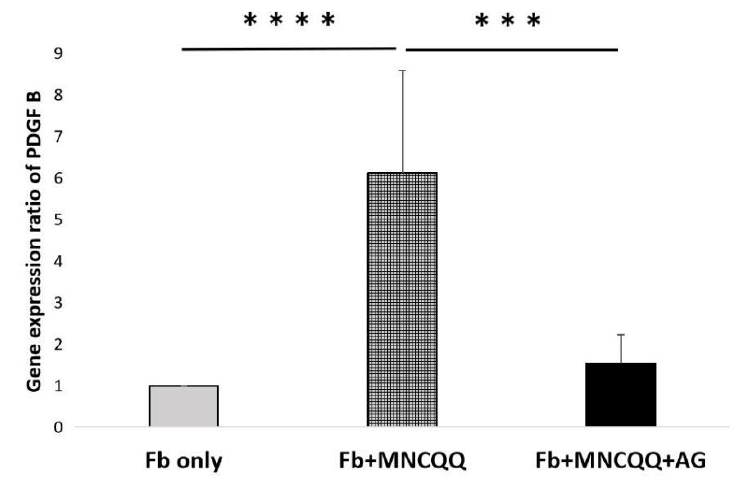
Figure 5. mRNA expression of PDGF B in fibroblasts under HG condition. Reverse transcription- quantitative polymerase chain reaction for the mRNA expression levels of PDGF B in fibroblast cells in the HG condition. N = 7 volunteers. ***; vs. Fb + MNCQQ, p < 0.005; ****; vs. Fb + MNCQQ, p < 0.001 Fb only: fibroblasts only in high glucose; Fb + MNCQQ: fibroblasts cocultured with MNCQQ cells in high glucose; Fb + MNCQQ + AG: fibroblasts cocultured with MNCQQ cells with AG applied in high glucose.